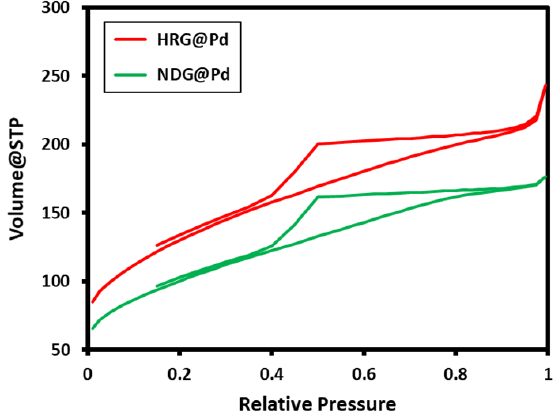
Figure 5. Figure 5. Adsorption – desorption isotherm of the highly reduced graphene-based palladium nanocatalyst (HRG@Pd) and the nitrogen-doped graphene-based palladium nanocatalyst (NDG@Pd).